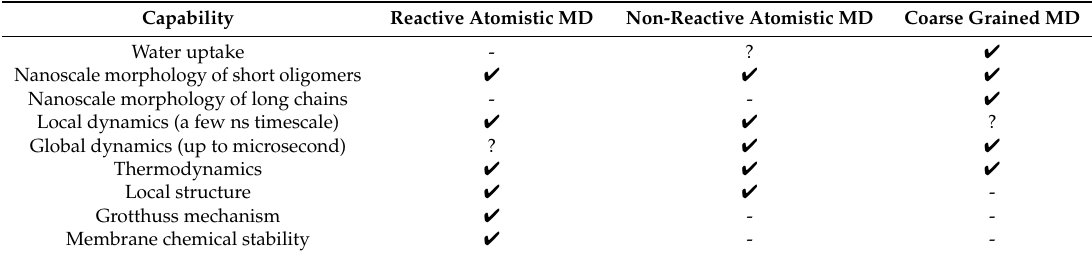
Table 1. The capability of different simulation models in retrieving properties of hydrated anion exchange membrane (AEM)*.